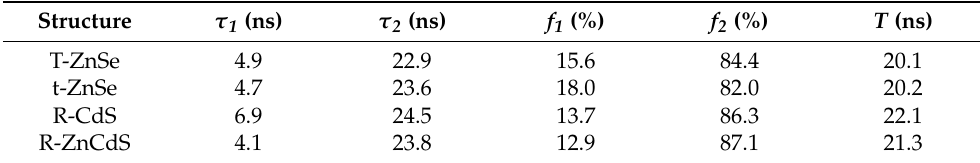
Table 1. PL decay for R-CdS, T-ZnSe, t-ZnSe and R-ZnCdS quantum dots; the nonradiative recom- bination decay component and its proportion ( τ 1 and f 1 ); the radiative recombination component and its proportion ( τ 2 and f 2 ); and the corresponding lifetime ( T ).